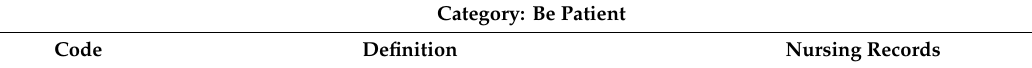
Table 4. Category, codes, and definitions of nursing records about clinical evolutions of